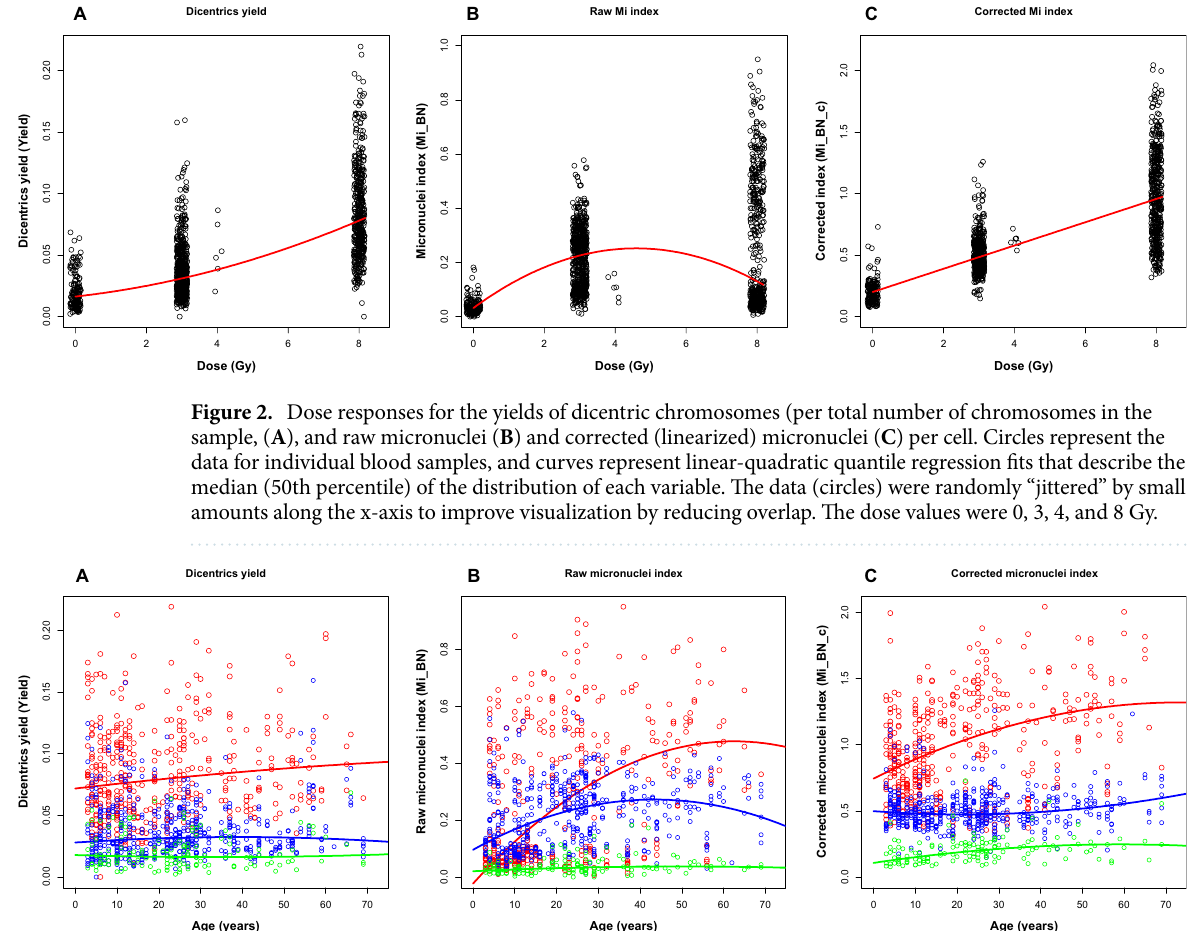
Figure 3. Age dependences for yields of dicentric chromosomes ( A ), and raw micronuclei ( B ) and corrected (linearized) micronuclei ( C ). Green = 0 Gy, blue = 3 Gy, red = 8 Gy. Circles represent the data for individual blood samples, and curves of each corresponding color represent linear-quadratic quantile regression fits that describe the median (50th percentile) of the distribution of each